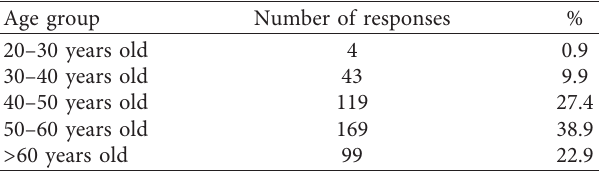
Table 2: IGSE administrators by age groups in Lvivska oblast. Age group